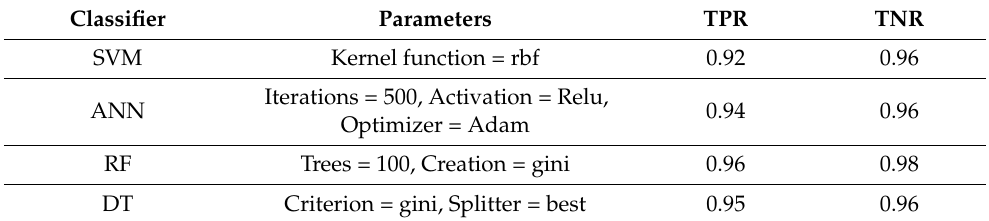
Table 3. Evaluation results and parameters used of the proposed classifiers.